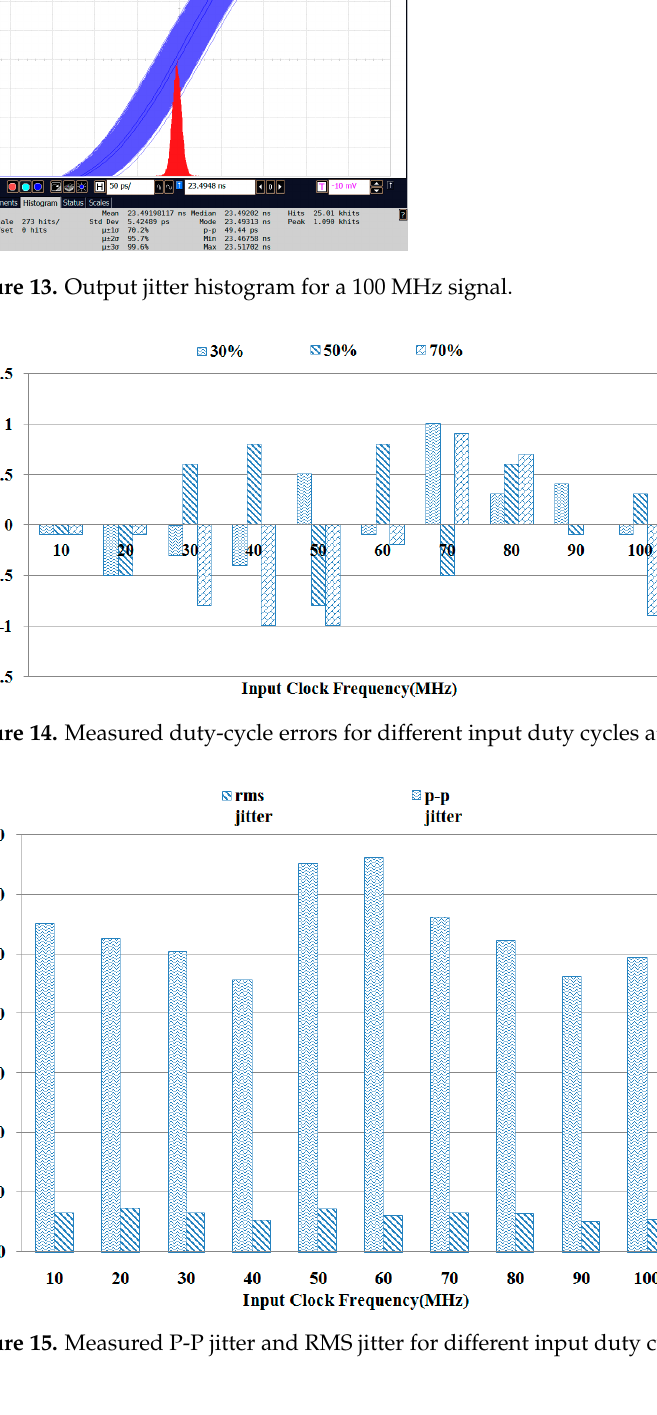
Figure 15. Measured P-P jitter and RMS jitter for different input duty cycles at 10–100 MHz. Table 1. Comparison with previous works.